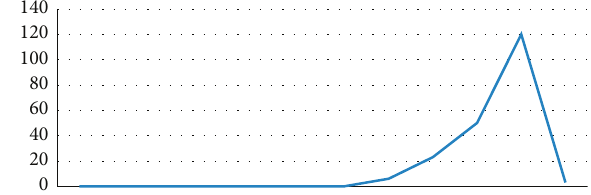
Figure 21: Article distribution by years for mapping review articles.